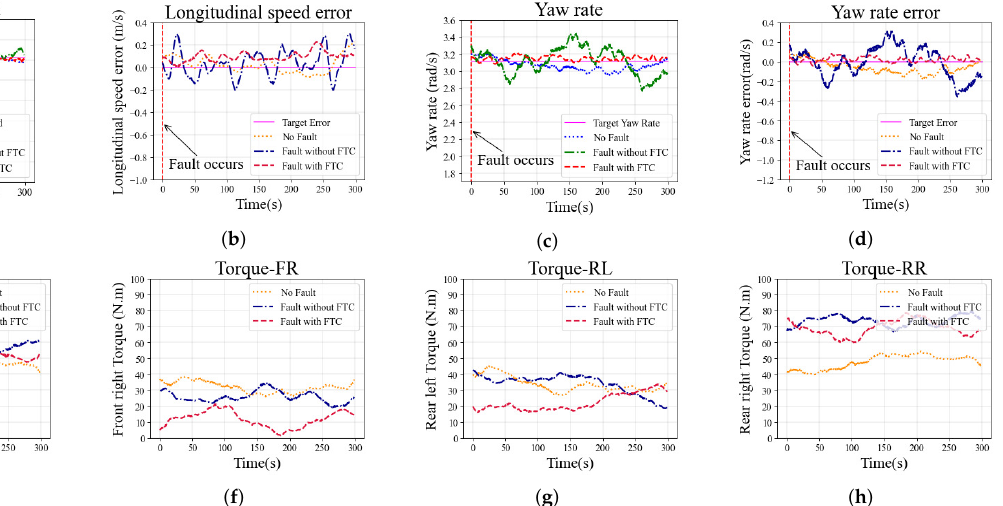
Figure 10. Simulation results in the constant steering scenario with fault F ∗ ( a ) Longitudinal speed; ( b ) Longitudinal speed error; ( c ) Yaw rate; ( d ) Yaw rate error; ( e – h ) Torque on each wheel (front left, front right, rear left, and rear